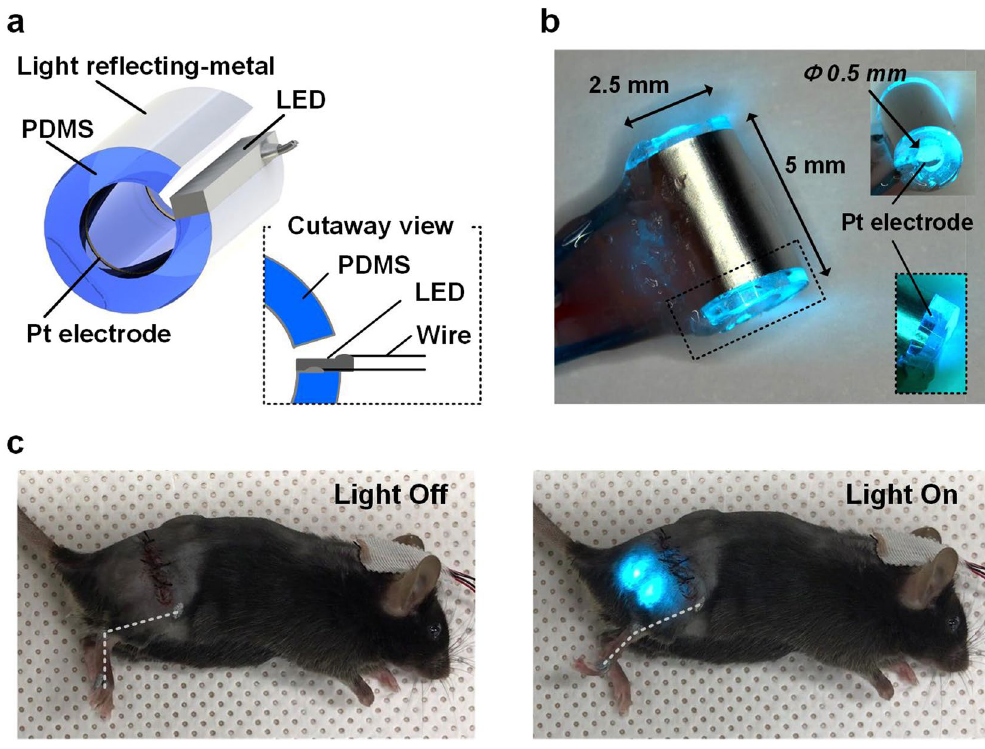
Figure 1. Optical nerve cuff electrode for optogenetic stimulation with simultaneous neural signal recording. ( a ) Overall schematic illustration of the optical nerve cuff electrode, ( b ) picture of an active device resulting in light illumination and ( c ) picture of an animal model for electrode